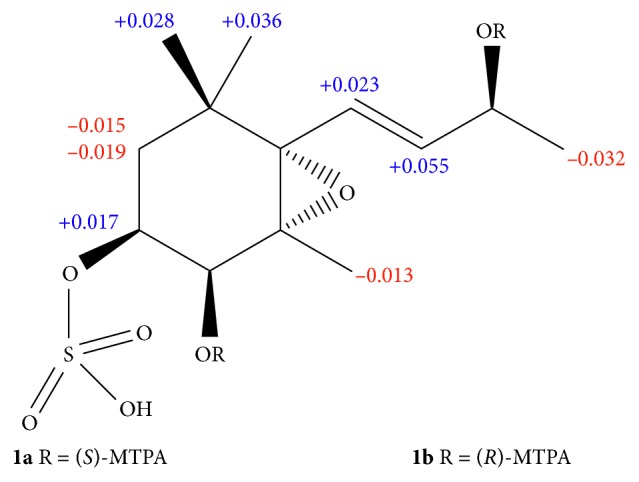
Δδ
H (S−R) values (in ppm) for MTPA esters of 1.